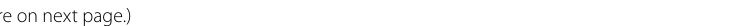
figure on next Fig. 2 25-year-old pregnant female at 35 weeks of gestation, with suspected renal anomalies. Prenatal ultrasound: a , b revealed sizable intra-abdominal mass indenting the liver occupying the right renal fossa…? renal in origin. Prenatal fetal MRI sequences revealed sizable soft tissue iso to hyperintense lesion at the anatomical site of right adrenal fossa (solid arrow) seen indenting the posteroinferior surface of the liver anteriorly and displacing still separable from the right kidney (hollow arrow) with no hemorrhagic foci as in T1 excluding hemorrhage …. features of sizable right suprarenal lesion (? neuroblastoma) … c , d Axial T2 SSFSE sequence, e sagittal T2 SSFSE sequence, f axial DWI sequence, g axial T1 gradient echo sequence. Diagnosis was sizable right suprarenal lesion (?